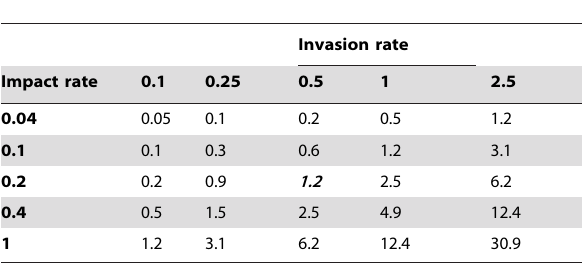
Table 3. Cisco extirpation (percent of current cisco populations) across a range of rainbow smelt invasion scenarios.